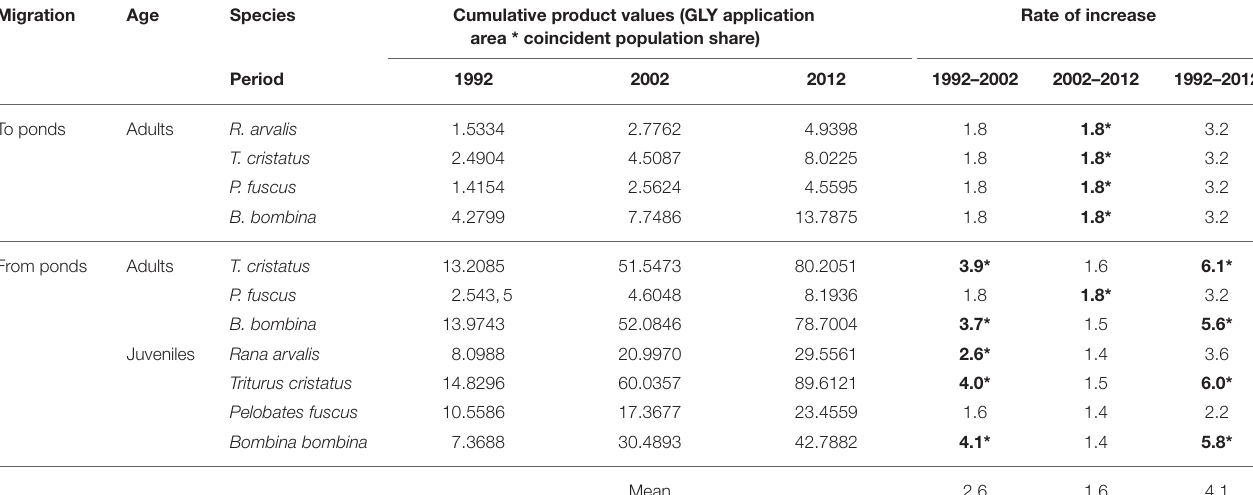
TABLE 1 | Cumulative product values and rate of increase according to migration, age and species (bold * indicates values above mean).